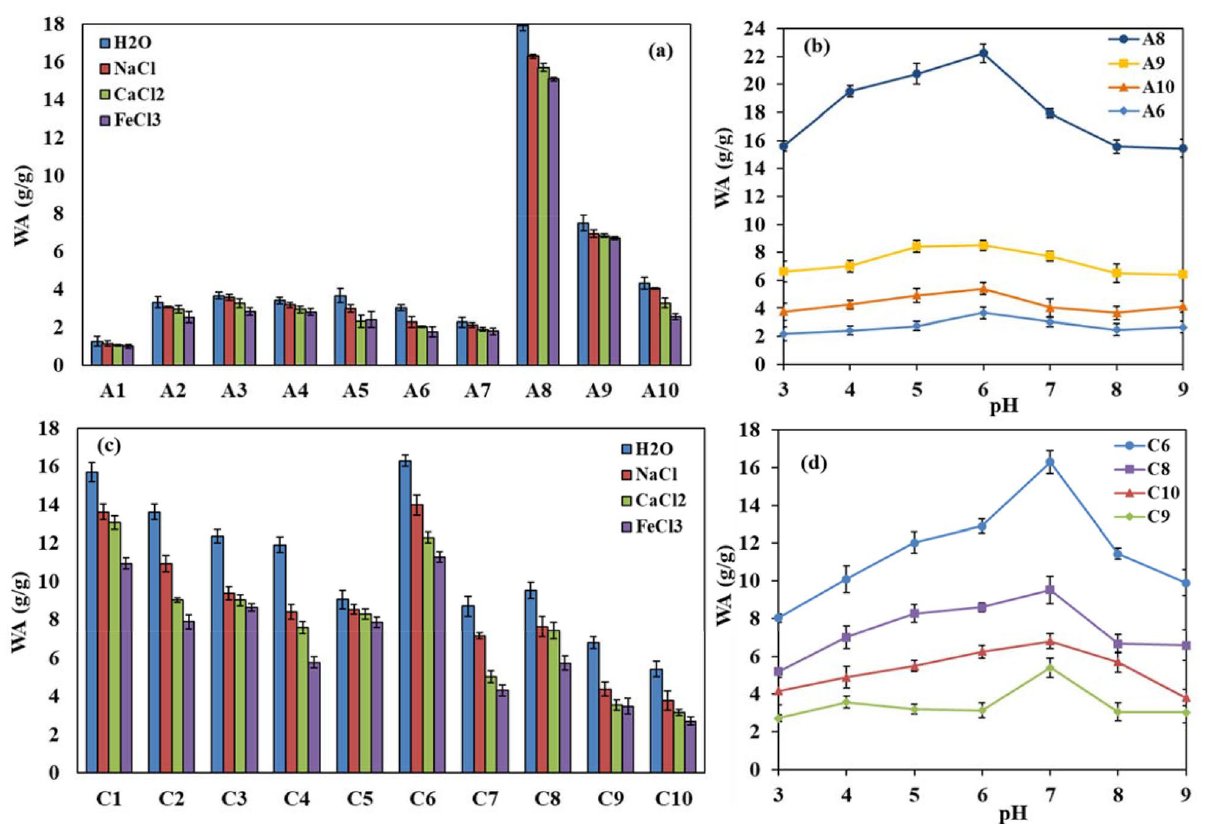
Figure 2. Effects of different ( a ) salt solutions, and ( b ) pHs on the water absorbency of the as-synthesized SA-based hydrogel samples; effects of different ( c ) salt solutions, and ( d ) pHs on the water absorbency of the as-synthesized CH-based hydrogel